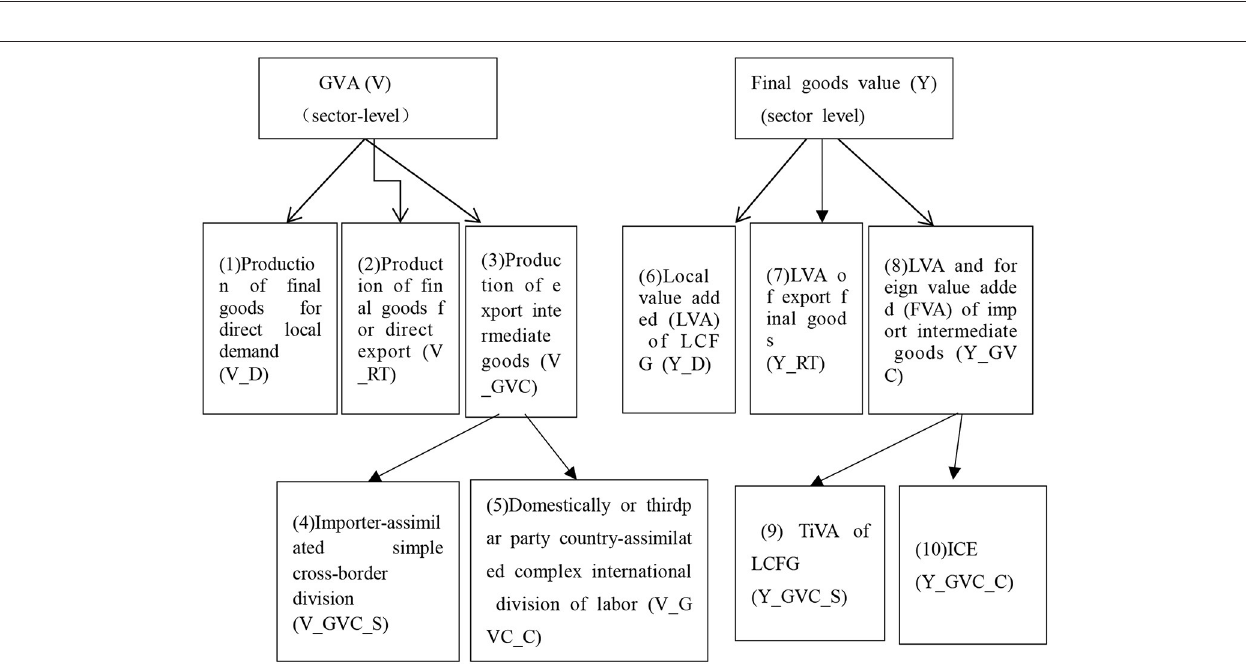
FIGURE 8 | WWYZ decomposition. The left and right drawings show the decomposition of gross value added (GVA) from the perspective of forward industrial linkage and backward industrial linkage, respectively [Source: Wang et al. (31)].